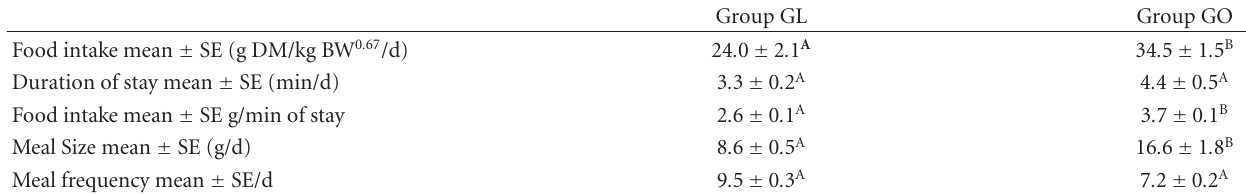
Table 4: Mean food intake, duration of single stays, food intake/min of stay, meal size, and meal frequency in the cat food station of the cats of group GL (lean phenotype) and GO (overweight phenotype), di ff erent letters show significant di ff erences ( P < 0 .